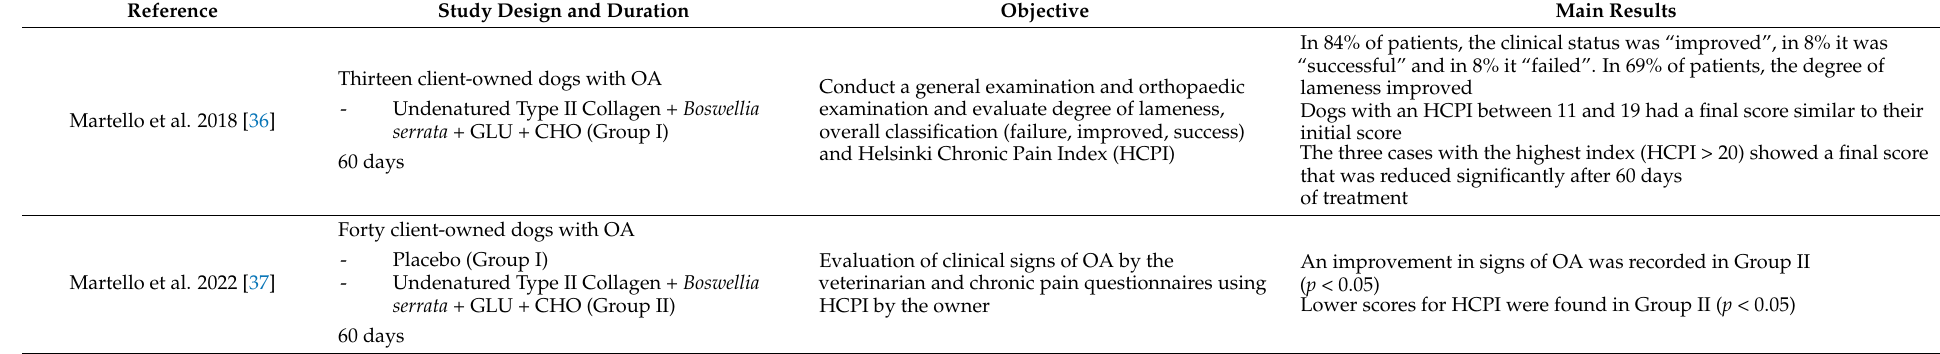
Table 7. Literature overview of evidence regarding the combination of Undenatured Type II Collagen and Boswellia serrata for the management of osteoarthritis (OA) and joint support in